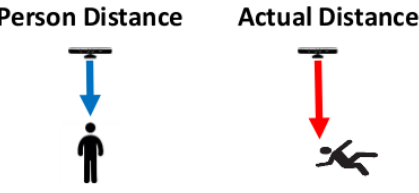
Figure 2. The person’s distance from the sensor is the distance when the person is standing. The actual distance, on the right, is the person’s distance from the sensor in the actual processed